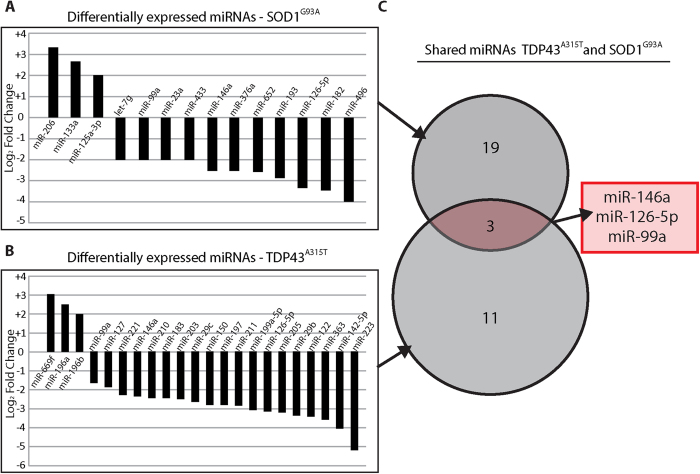
ALS models - axonal microRNA.Differentially expressed microRNA (FC > 2 or FC < −2, p-value < 0.05) logarithmic bar plots in cultures of the SOD1G93A (A) and TDP43A315T (B) ALS models. (C) Venn diagram of microRNAs in A&B. Shared microRNAs are written below the diagram.